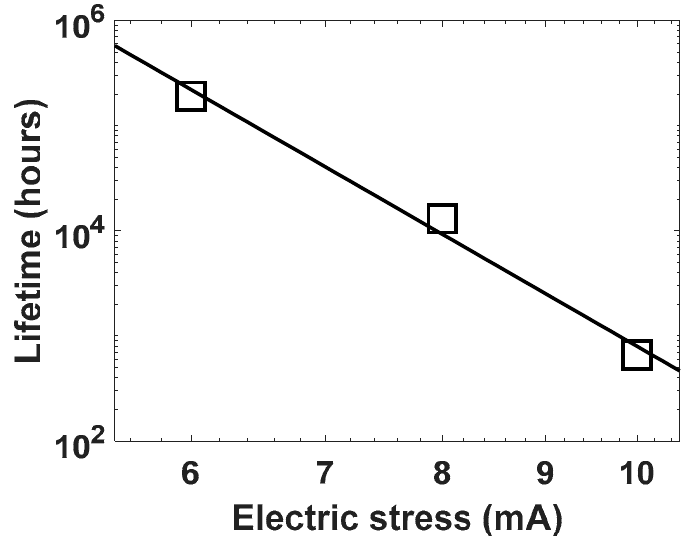
Figure 7. Variation of device life with electrical stress.